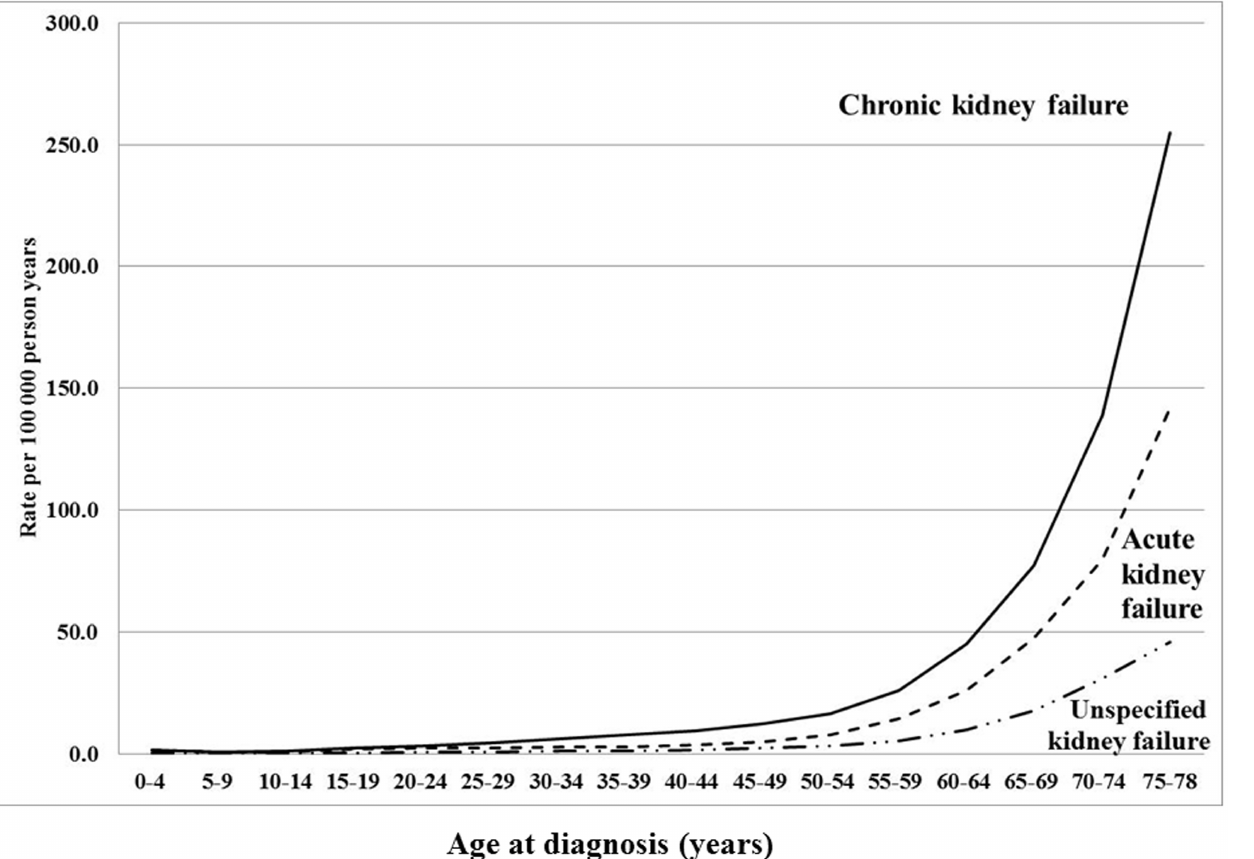
Figure 2. Age-specific incidence rates (per 100000 person years) of chronic kidney failure, acute kidney failure, and unspecified kidney failure ( 5 others) in offspring/siblings born in 1932 and